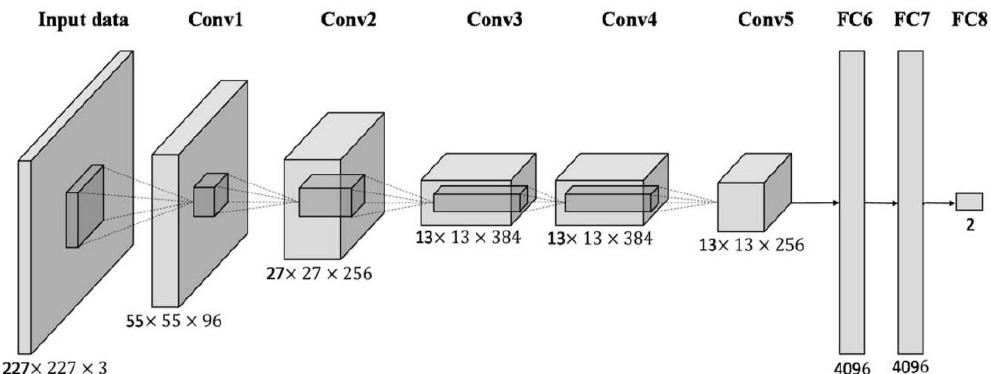
Figure 3. Schematic of the AlexNet architecture. The output has been replaced considering the two classes on which to discriminate.